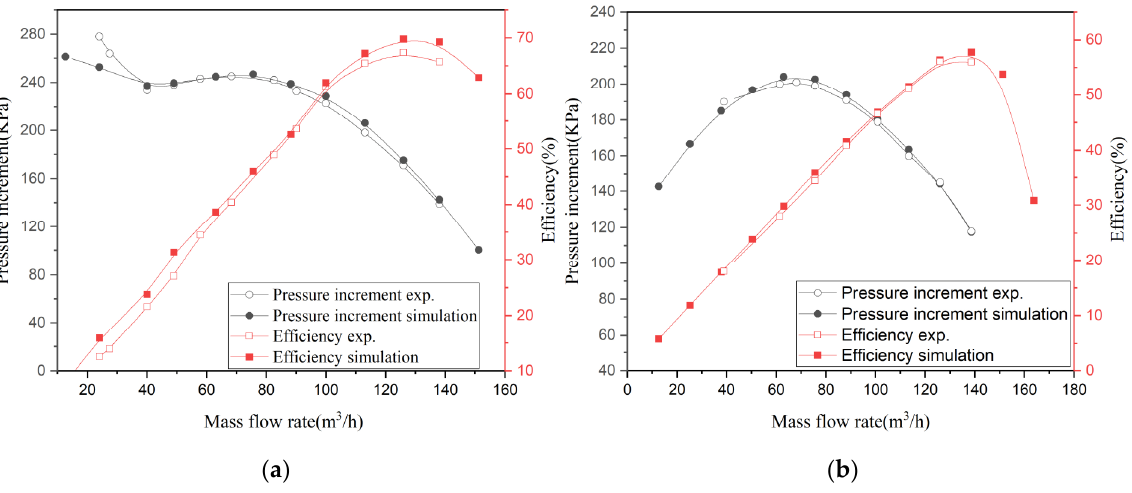
Figure 22. Experimental results of the multiphase pump performance parameters compared with simulation results. ( a ) The water condition; ( b ) GVF = 20%. simulation results. ( a ) The water condition; ( b ) GVF =